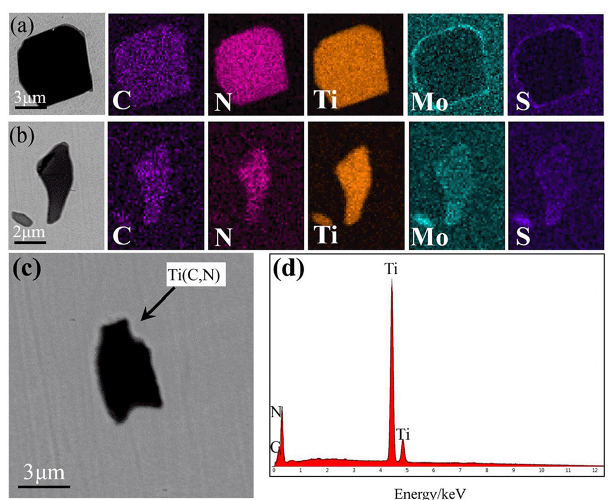
Figure 6. SEM images and EDS maps of the primary inclusions in ingot #2: ( a , b ) Ti(C, N) ‐ MoS; and ( c , d ) Ti(C, N).